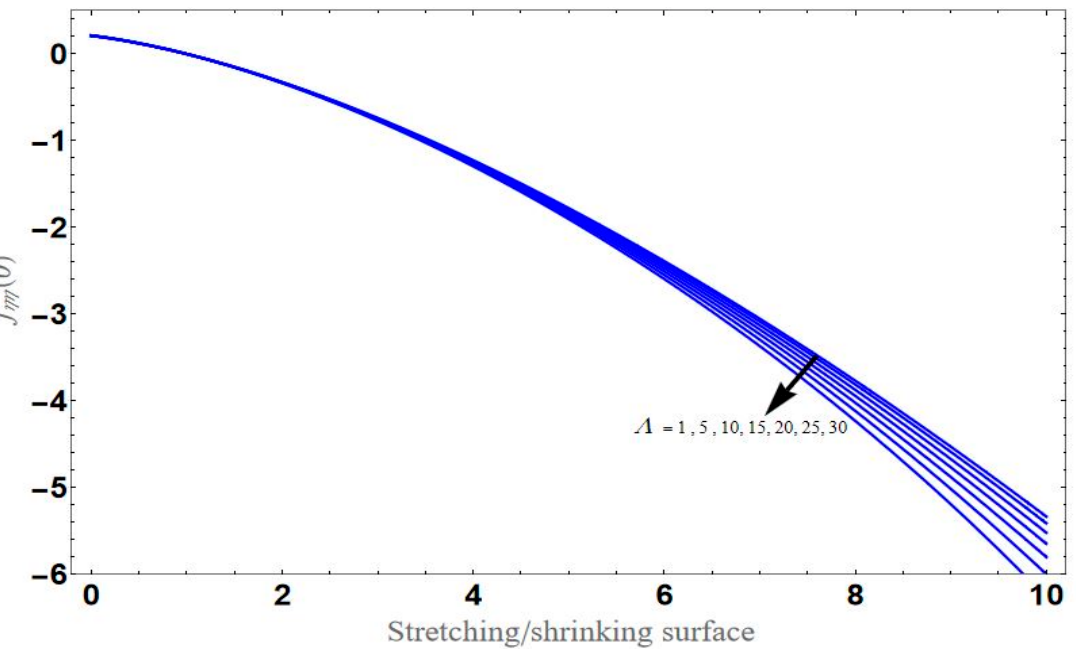
Figure 18. Variation of C f Re x 1/2 with respect to the stretching/shrinking surface for different values of couple stress Λ .